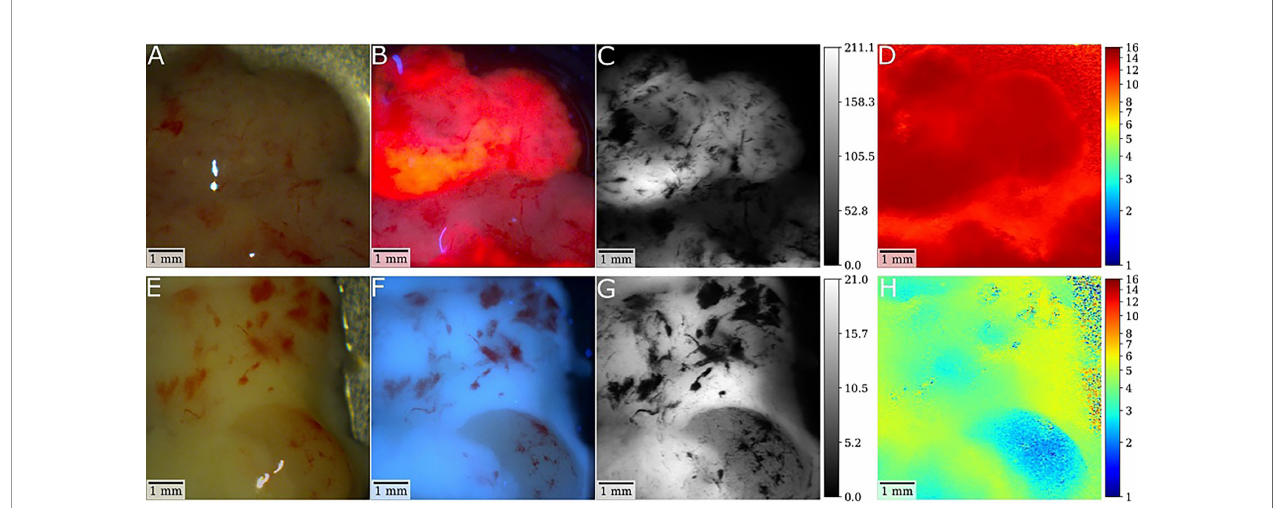
FIGURE 2 | Illustrative cases of a glioblastoma (GBM) and low-grade glioma (LGG) with postsurgical ex-vivo analysis with fl uorescence lifetime imaging after preoperative 5-ALA administration. (A, B) In the fi rst patient, white-light and fl uorescence camera images show the tumor core of an IDH-wild-type GBM specimen. For the fl uorescence image, the laser was scanned rapidly across the tissue with the integration time of the camera being set to 2 seconds. Note the strong visible PpIX fl uorescence of the sample. Demodulated fl uorescence intensity [mV RMS ] and fl uorescence lifetime [ns] images of a raster-scanning FD-FLIM system are shown in (C, D) . As depicted by the color-coding, strong PpIX fl uorescence led to increased lifetimes up to 15.3ns with a mean lifetime of 13.4ns. (E, F) In the second patient, respective images show a tissue specimen of an IDH mutated low-grade astrocytoma (G, H) . While no fl uorescence was visible intraoperatively, the lifetime was increased from about 2.4 to 5.5ns, which is higher than the 0.8 to 2ns expected for non-pathological brain parenchyma. Thus, this tumor tissue could be visualized by fl uorescence lifetime